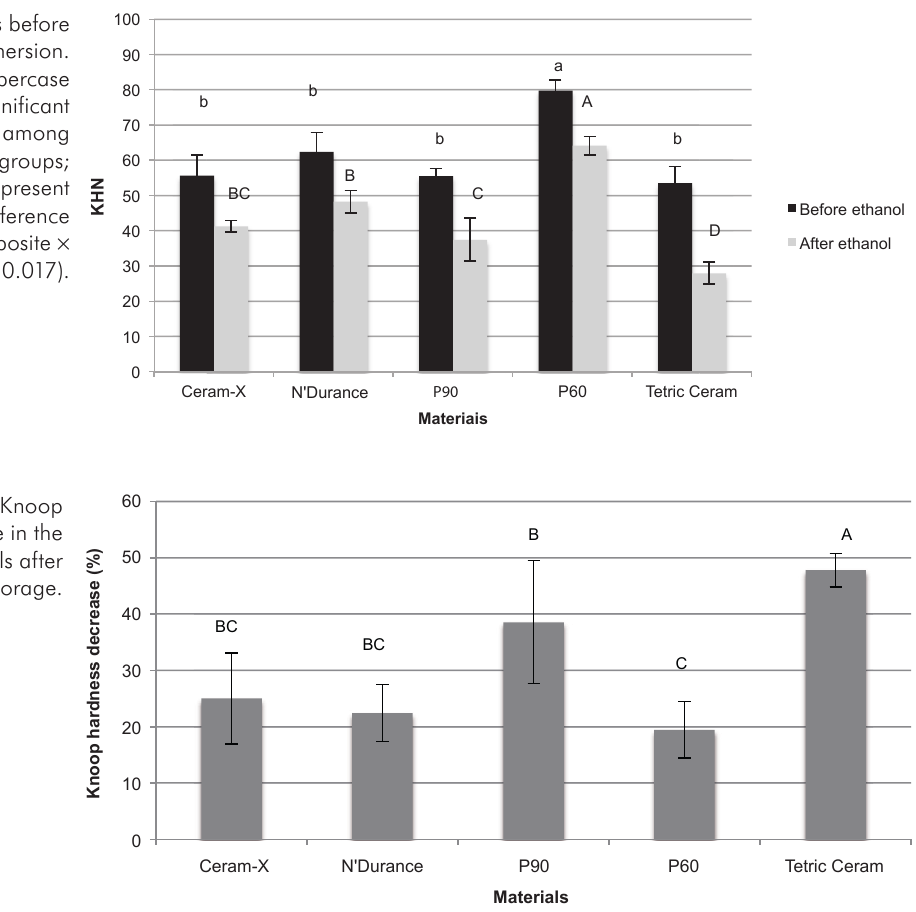
Figure 2 - Percentage of Knoop hardness decrease in the tested materials after ethanol storage.